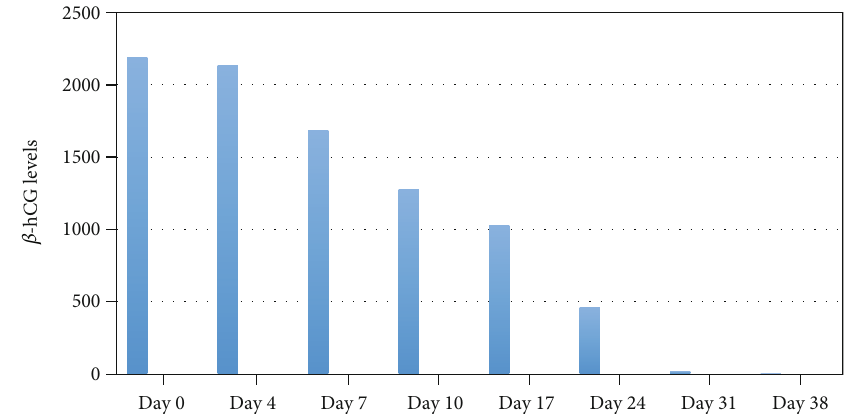
Figure 6: Chronogram of the serum β -hCG values.